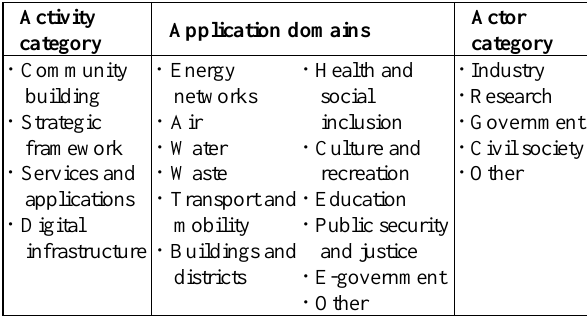
Table 1. Three classification systems of smart city activities (Mora and Deakin, 2019)